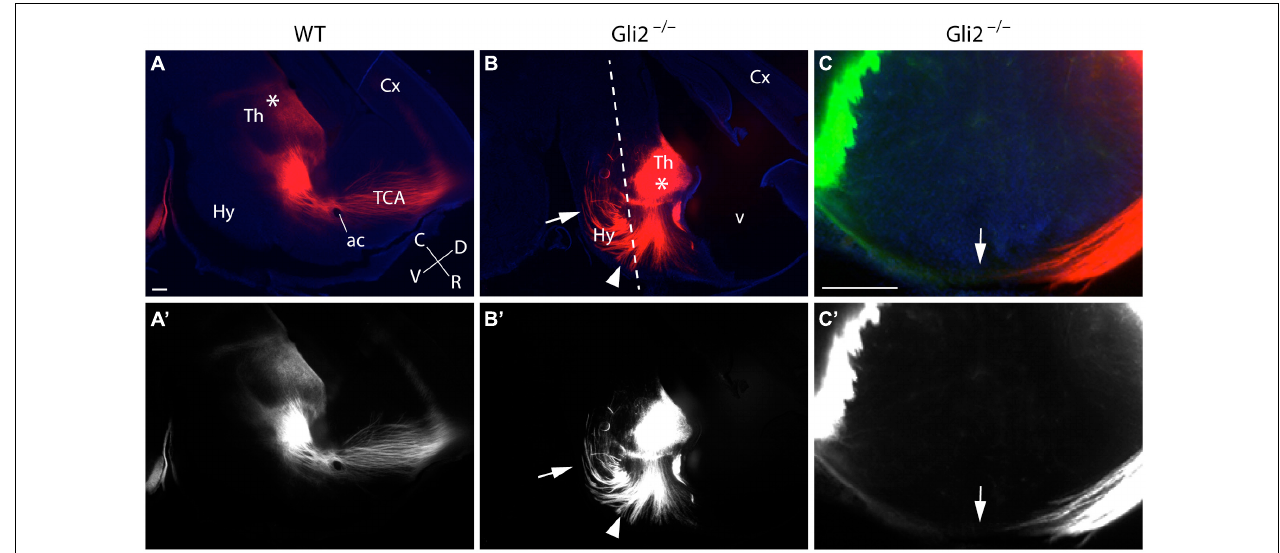
FIGURE 3 | DiI/DiA labeling of thalamocortical axons (TCAs) in Gli2 mutant mice. Selected sagittal vibratome sections (100 µ m) through the forebrain of E18.5 embryos WT (A,A’) and Gli2 − / − (B,B’) labeled with DiI (red color). Transversal sections (C,C’) through the forebrain of E18.5 embryos Gli2 mutant labeled with DiI (red color) and DiA (green color). DiI implanted in wild-type Th labeled the normal route of the TCAs along the forebrain until they reach the cortex (Cx; A,A’ ). DiI placed in the Th of Gli2 − / − brains labeled bundles of axons misrouted rostrally, caudally (arrow), and ventrally toward the THy (arrowhead; B,B’ ). Samples sectioned in a transversal plane of section to the hypothalamus [dotted line in (B) ] to show the final destination of the axons in the Thy, the arrow indicates the floor midline of the Thy (C,C’) . Asterisks in (A,B) indicate the DiI/A crystal placement sites. The images displayed in (A–C) are shown in black and white (A’–C’) to facilitate the observation of the labeled axons. ac, anterior commissure; C, caudal; Cx, cortex; D, dorsal; Hy, hypothalamus; R, rostral; TCA, thalamocortical axon; Th, thalamus; V, ventral. Scale bar: 300 µ